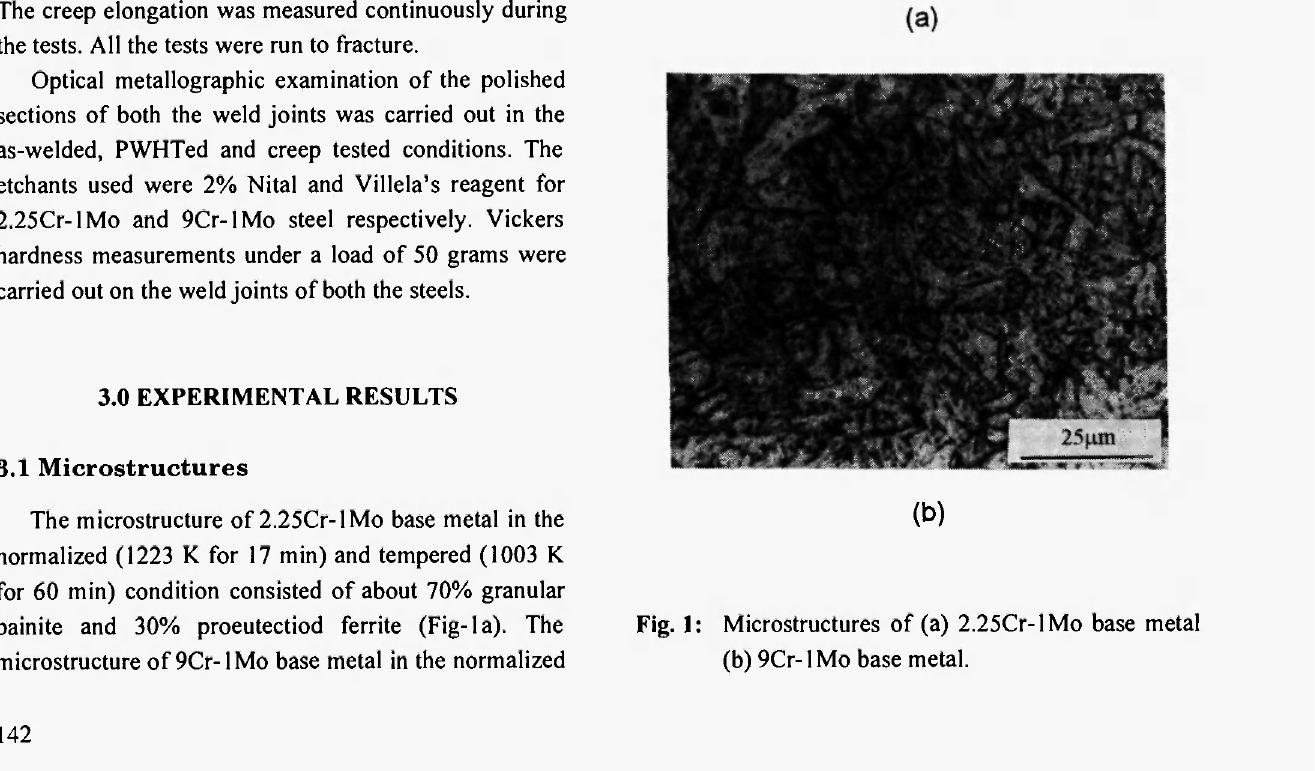
Fig. 1: Microstructures of (a) 2.25Cr-lMo base metal (b) 9Cr-lMo base